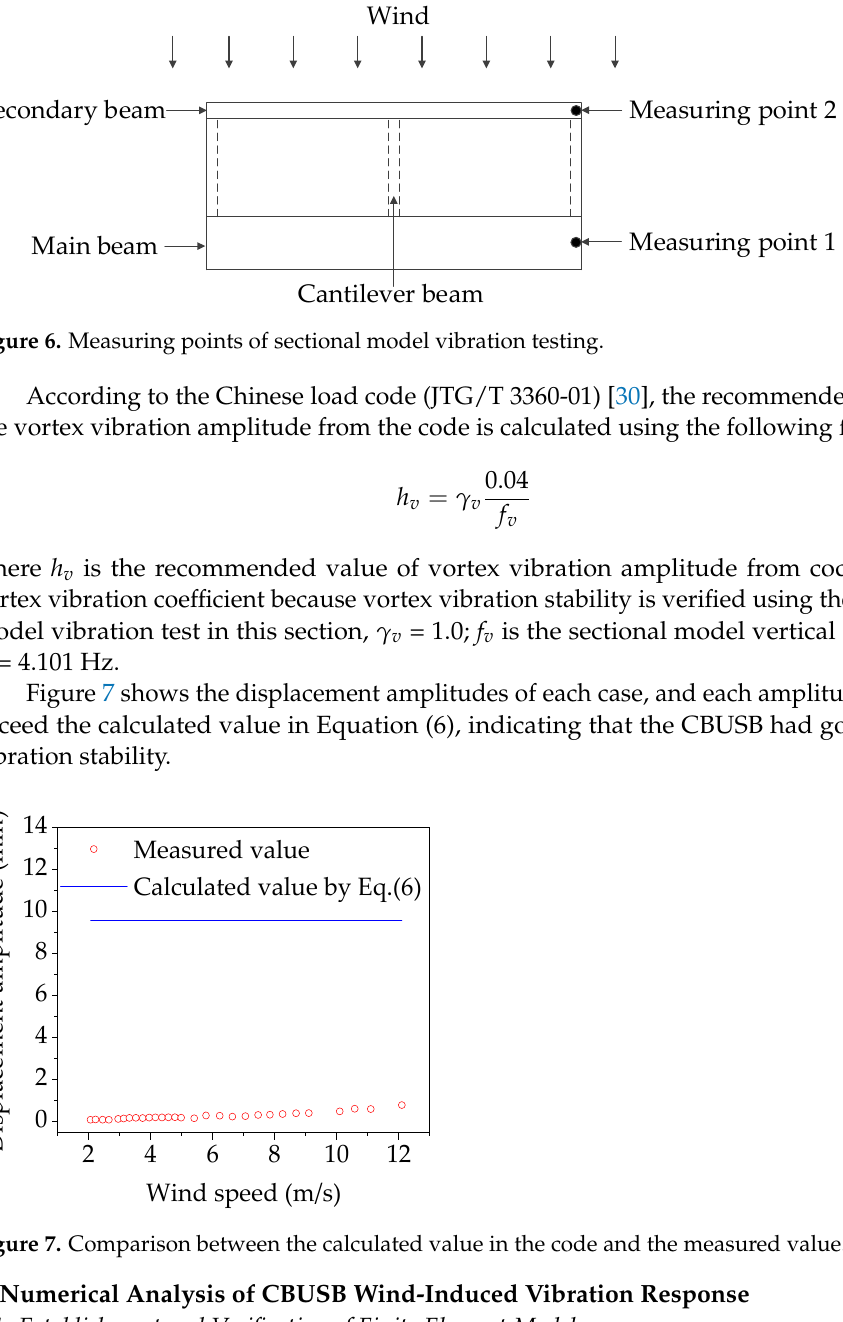
Figure 5. The distribution of aerodynamic coefficients with a wind attack angle.